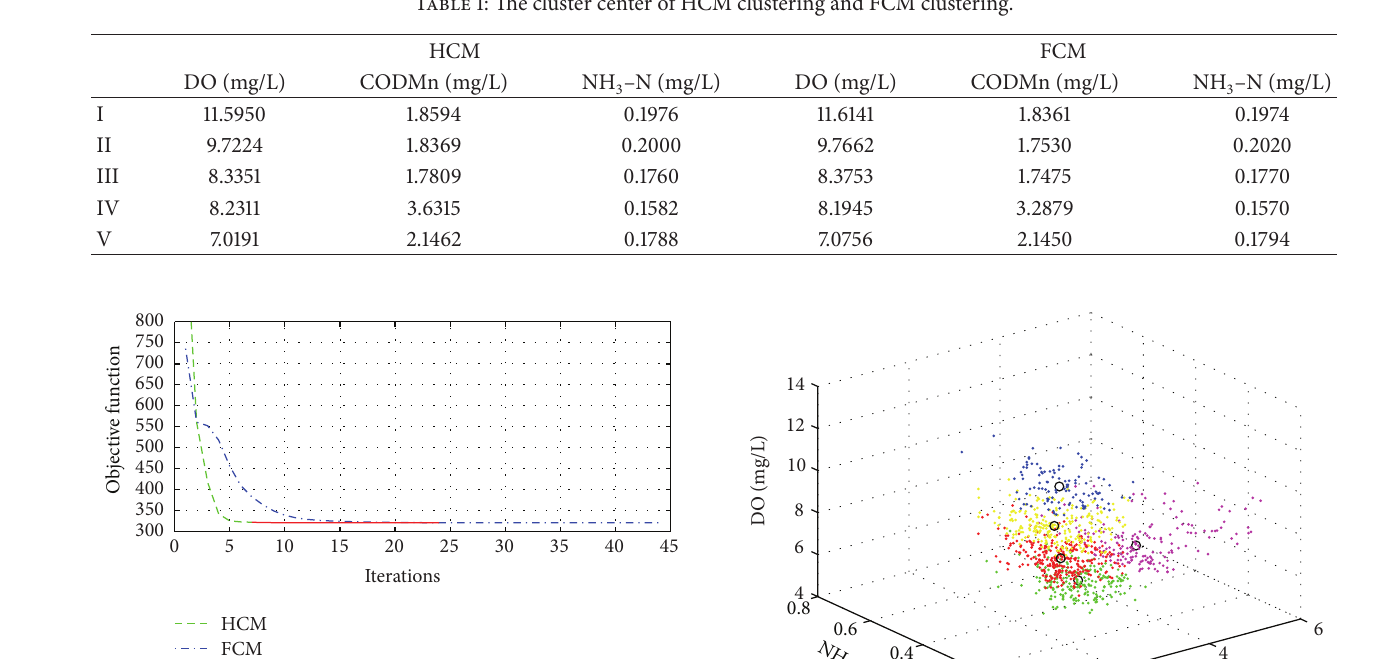
Table 1: The cluster center of HCM clustering and FCM clustering.